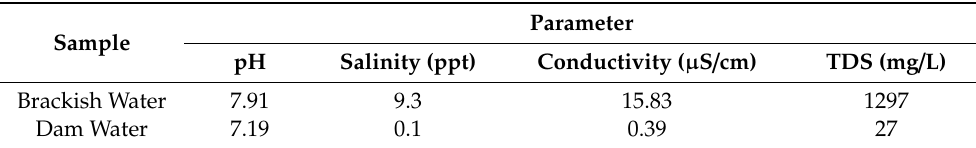
Table 1. The quality of the feed water used in the FO